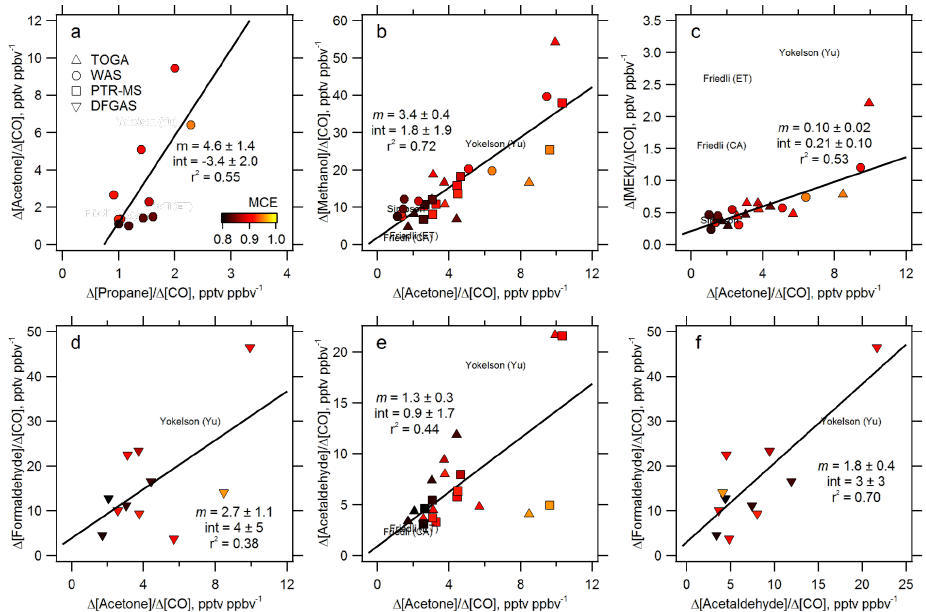
Fig. 10. Similar to Figs. 8 and 9, comparison plots of the NEMRs to CO observed during ARCTAS for oxygenated NMOC, colored by plume MCE. Also shown are the corresponding literature NEMR ratios listed in Table 3. In (d) and (f) , formaldehyde NEMRs to CO from ARCTAS are plotted against NEMRs determined using TOGA data.